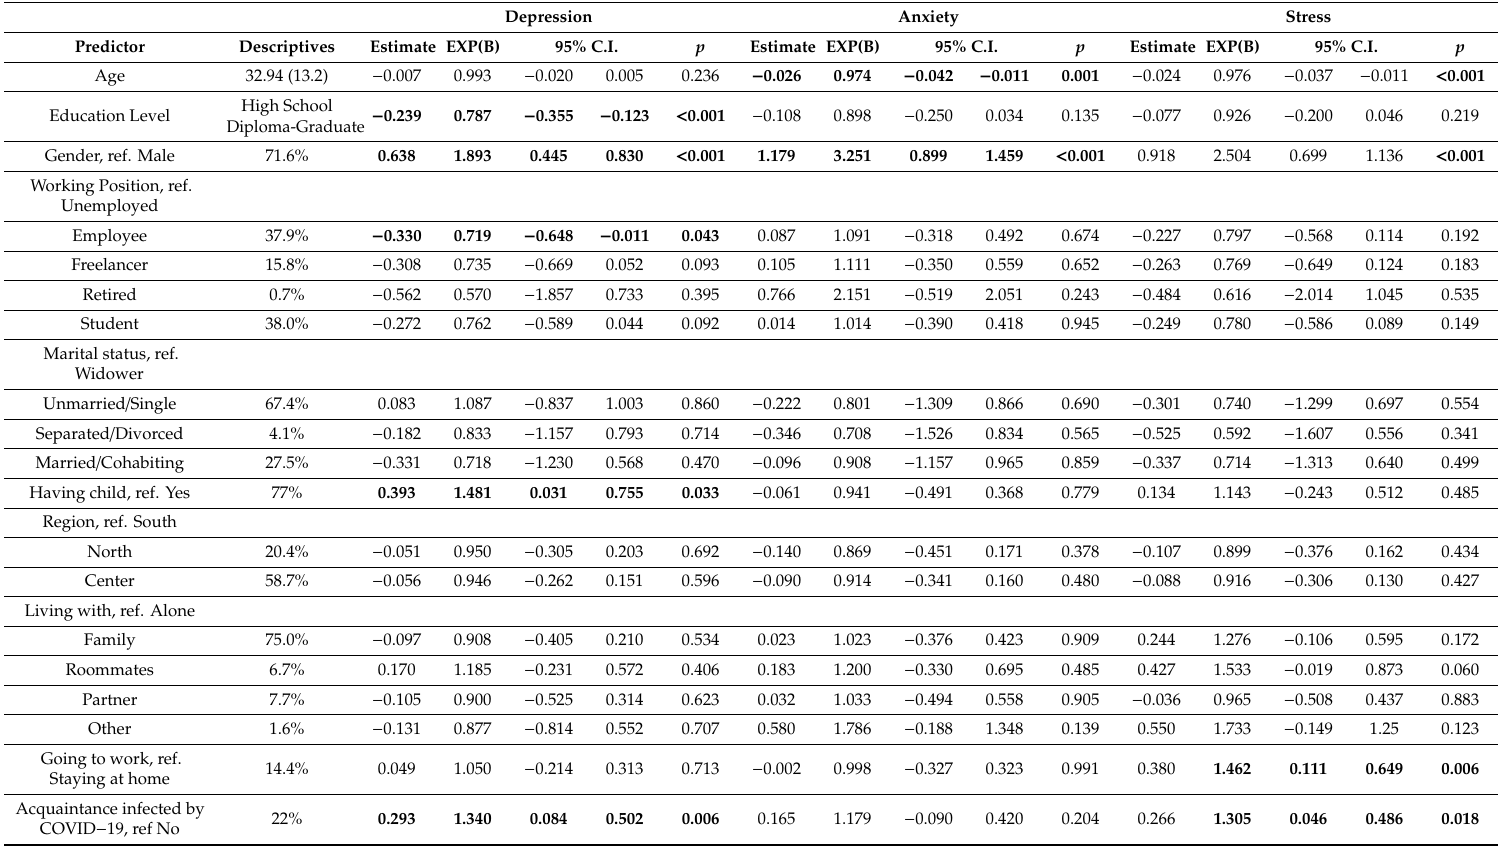
Table 3. Associations between sociodemographic variables and DASS-21 depression, anxiety, and stress levels during the COVID-19 outbreak. Depression Anxiety Stress Predictor Descriptives Estimate EXP(B) 95% C.I. Estimate EXP(B)